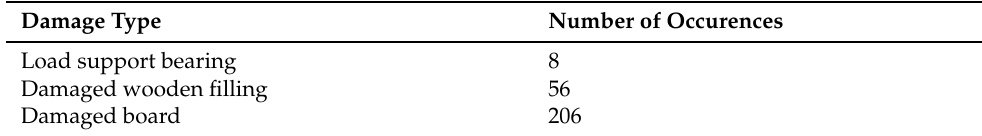
Table 1. Class distribution of wooden load space